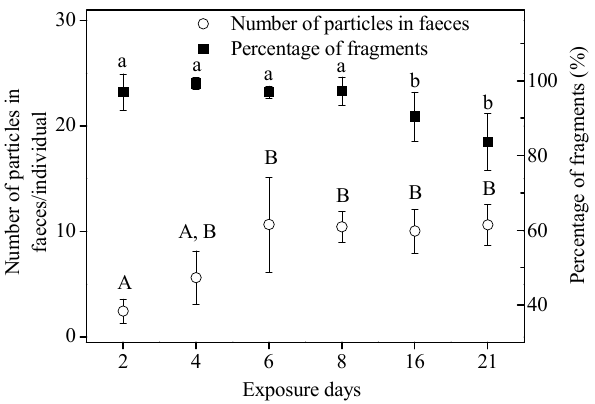
Figure 6. Number of particles in feces collected at Day 2, 4, 6, 8, 16, and 21 during the 21-d exposure. Different letters above columns indicate significant differences (ANOVA, p < 0.05).